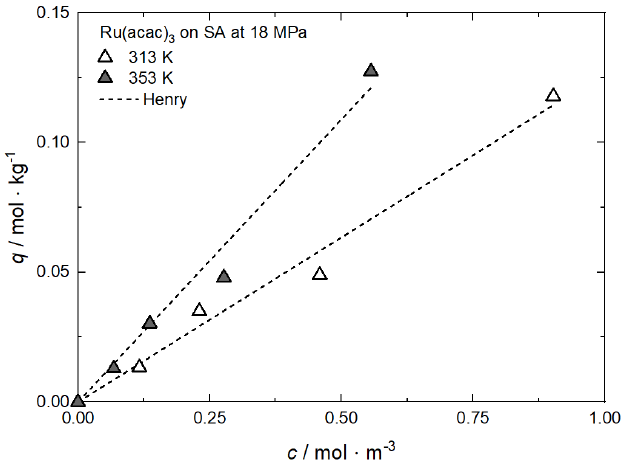
Figure A5. Uptake of Ru(acac) 3 on SA at 18 MPa and different temperatures; experimental data taken from [23]. Table A5. Adsorption isotherm parameters for Ru(acac) 3 from scCO 2 solution on SA at 18 MPa and different temperatures [23].